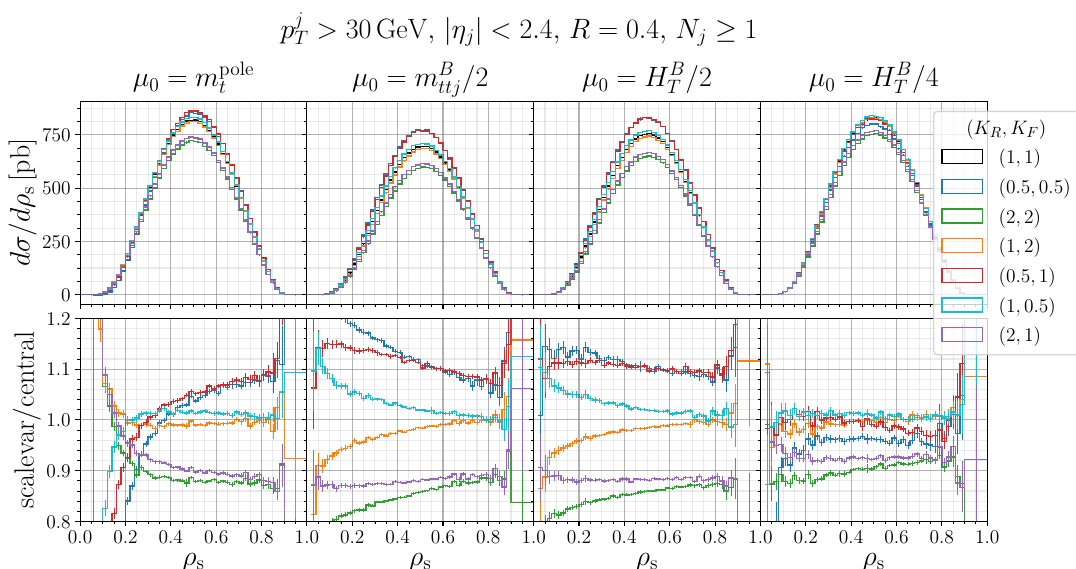
Figure 4 . NLO differential cross section as a function of ρ s for the pp → t ¯ tj + X process at √ S = 13 TeV using as central scales the static scale µ 0 = m t (left panel) and the dynamical scales µ 0 ∈ { m B / 2 , H B / 2 , H B / 4 } . Thereby the seven-point scale variation graphs are explicitly drawn T T t ¯ tj and the ratio between these and the central scale predictions are shown in the lower ratio plot. Due to low statistics for large values of ρ s the distribution was rebinned, such that the region ρ s ∈ [0 . 9 , 1] corresponds to one